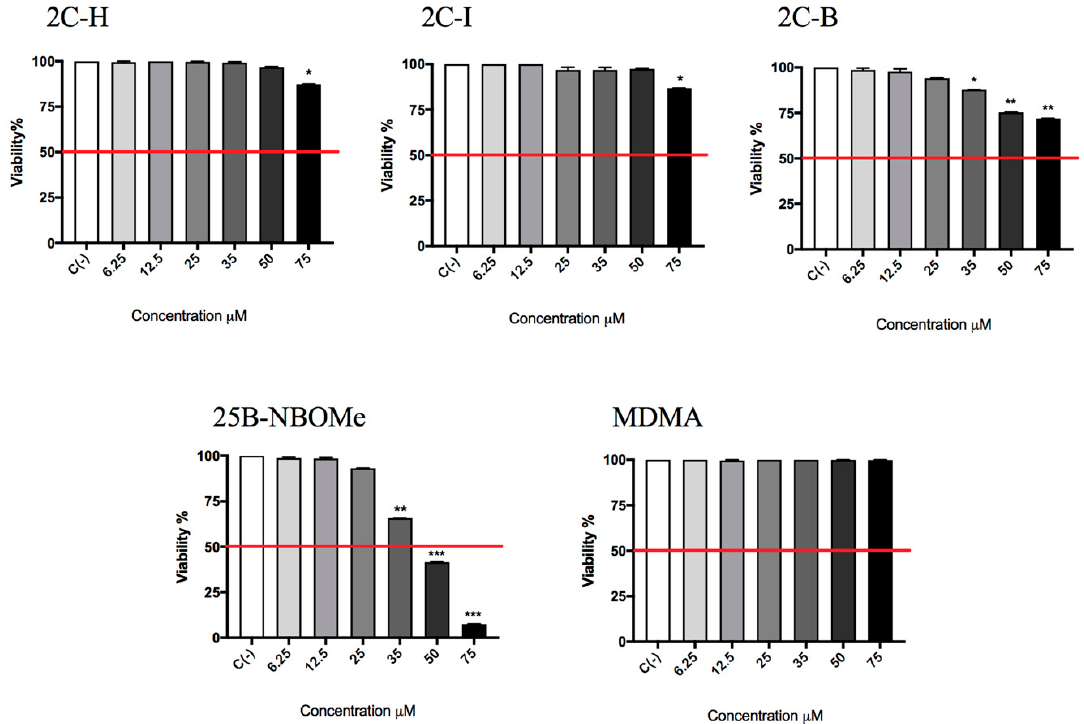
Figure 2. Cell viability on TK6 cells after 26 h treatment with 2C-H, 2C-I, 2C-B, 25B-NBOMe, and MDMA at the indicated concentrations with respect to the untreated control C (-). Each bar represents the mean ± SEM of five independent experiments. Data were analysed by ANOVA Repeated, followed by a Dunnet post-test. * p < 0.05 vs. C (-), ** p < 0.01 vs. C (-), *** p < 0.001 vs. C (-). The red line indicates the OECD threshold to be complied with for this genotoxicity test.